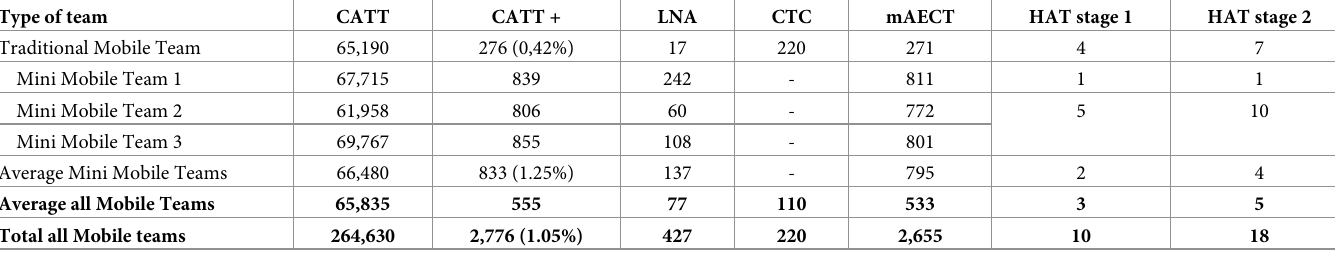
Table 3. Number of tests performed, and HAT cases identified between May 2017 and April 2018. Type of